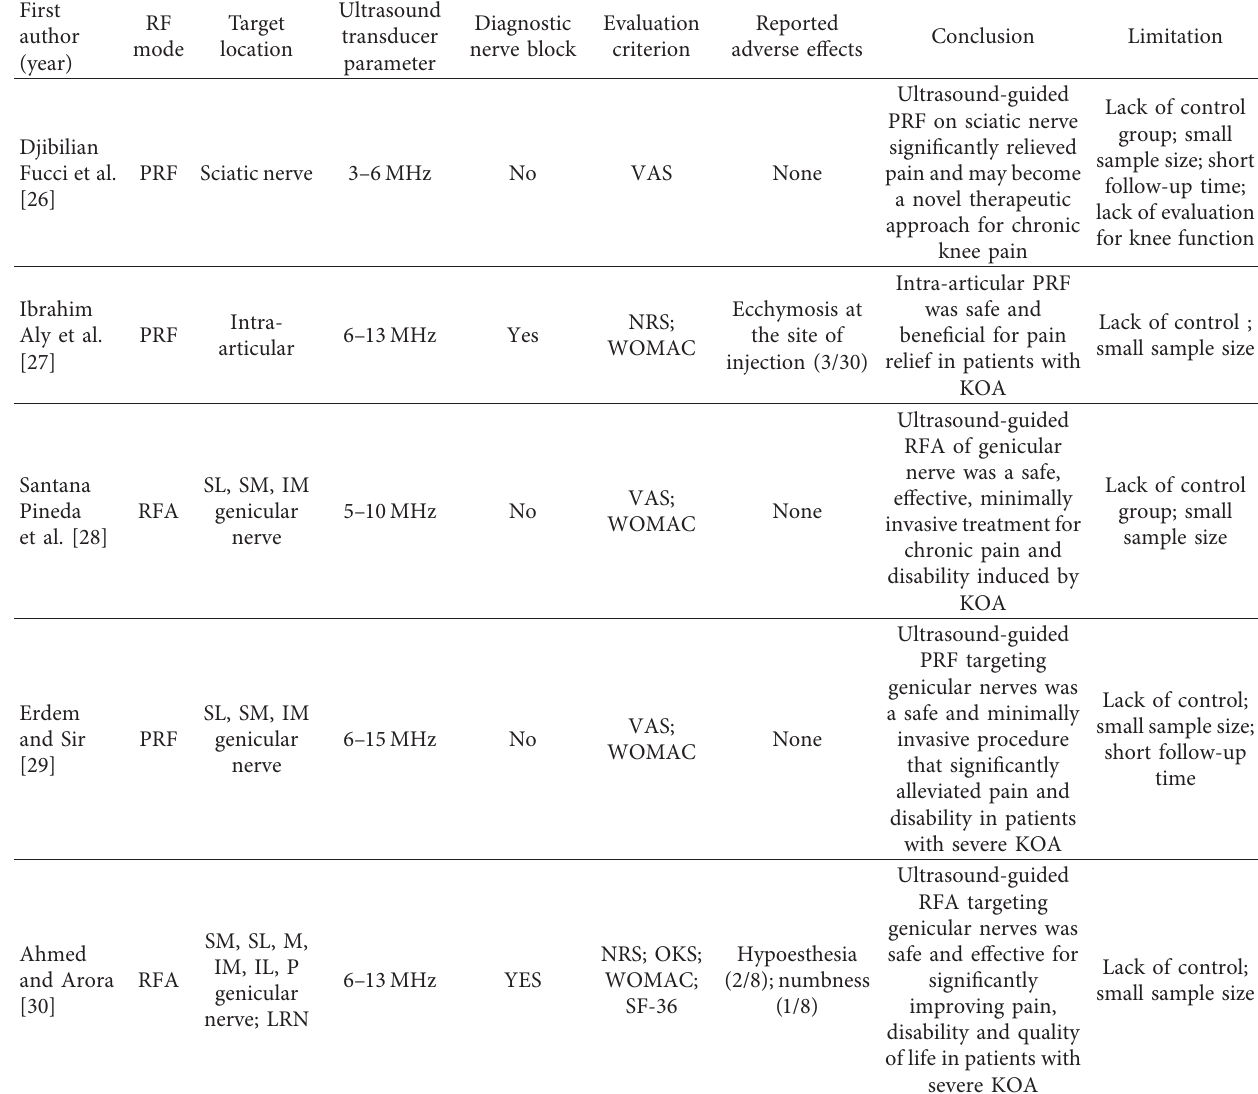
Table 3: Details of intervention, evaluation criterion, adverse effects, conclusion, and limitation of the nonrandomized